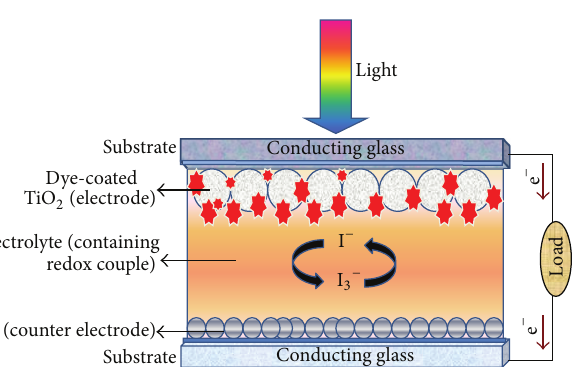
Figure 3: Schematic diagram of dye-sensitized solar cell (DSSC)